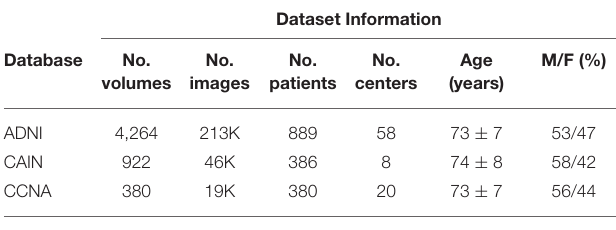
TABLE 1 | Summary of ADNI, CAIN, and CCNA